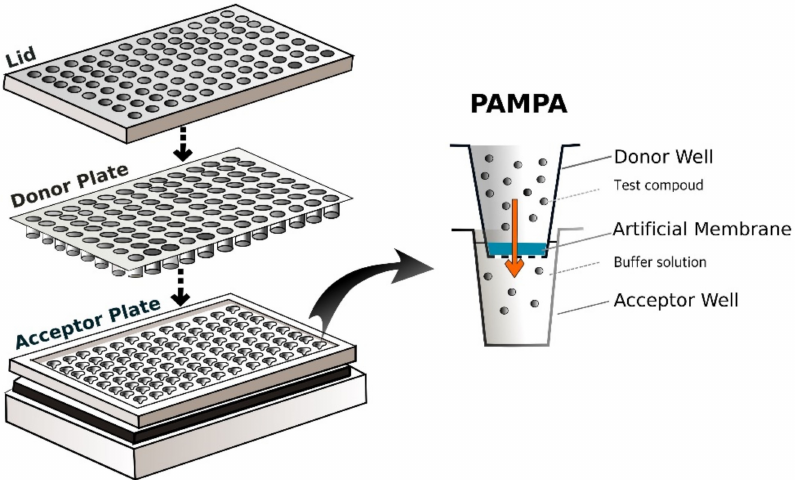
Figure 4. Parallel Artificial Membrane Permeability Assay (PAMPA) 96-well setup (left); a single well of PAMPA